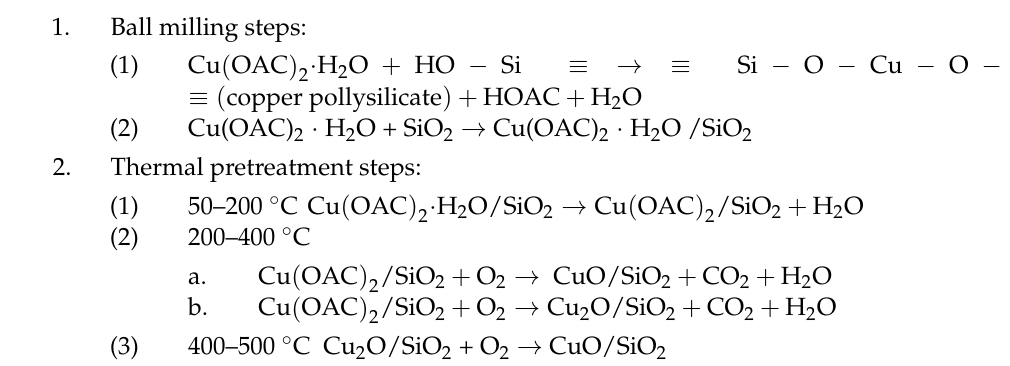
Scheme 1. Simplified diagrammatic evolution of W% Cu-A-BM catalysts.